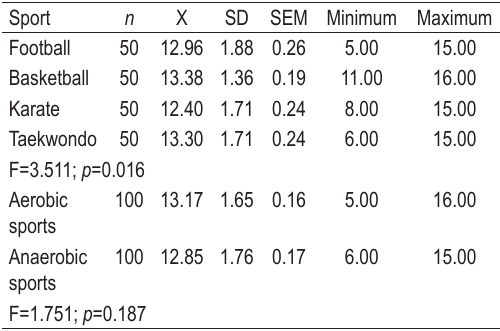
TABLE 1. The average age of patients